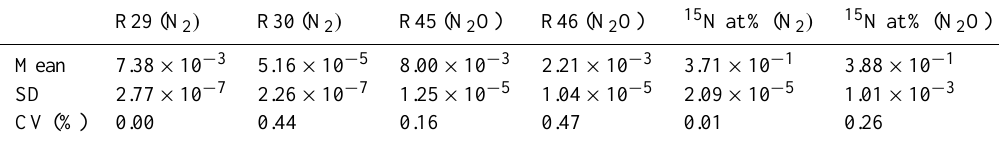
Table 1. Measured ratios of R29 and R30 for N 2 in ambient air ( n = 10), ratios of R45 and R46 in standard N 2 O gas (0.5ppm concentration, n = 15), and 15 N at % abundance calculated from the respective ratios for both gases. SD: standard deviation; CV: coefficient of